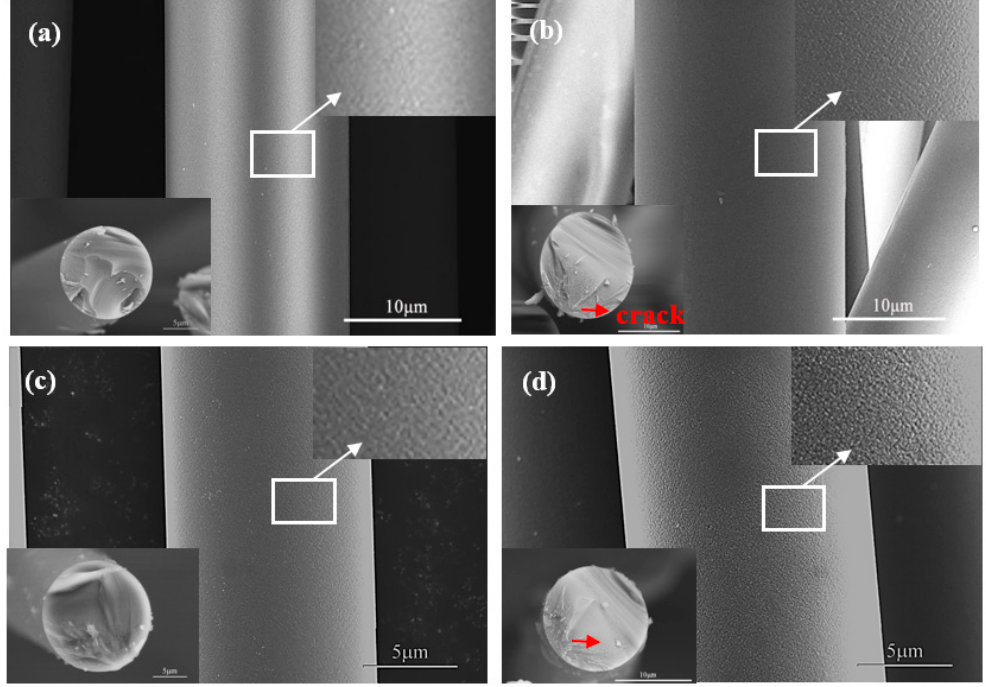
Figure 6. Surface and cross-section (insets) morphologies of ( a , b ) Si 3 N 4 fiber-L and ( c , d ) Si 3 N 4 fiber-H prior to and following heat treatment.